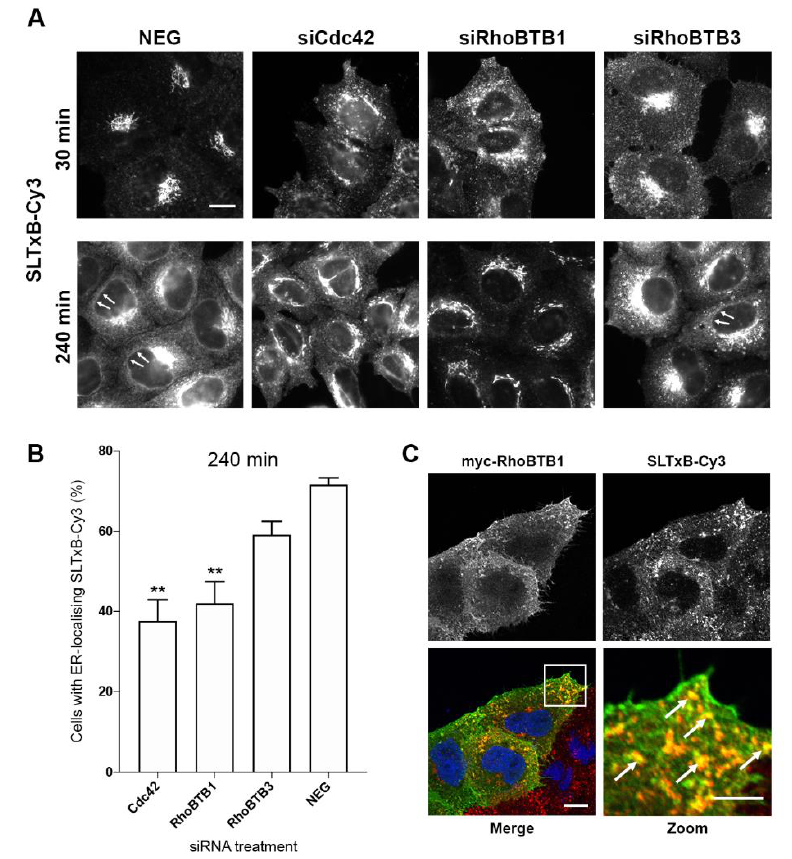
Figure 4. RhoBTB1 depletion affects retrograde transport of SLTxB-Cy3. ( A ) Representative images of HeLa Kyoto cells treated with siRNAs for 72 h as indicated and incubated with SLTxB-Cy3 for 30 or 240 min. In NEG control siRNA-treated cells, SLTxB-Cy3 is present at the Golgi complex after 30 min of incubation and at the ER after 240 min of incubation at 37 °C, as seen by the presence of the nuclear envelope signal (arrows). Bar represents 10 μm. ( B ) Graph of the mean % of cells displaying ER-localising SLTxB-Cy3 after 240 min of incubation in cells treated with siRNAs for 72 h, as indicated. Results are presented as mean ± s.e.m. of three independent experiments, with a total of at least 220 cells analysed. ** p < 0.01 compared with NEG control cells. ( C ) HeLa Kyoto cells were transfected with a DNA construct encoding myc-RhoBTB1 for 18 h and then incubated with SLTxB-Cy3 for 30 min. Arrows indicate myc-RhoBTB1 (green) and SLTxB-Cy3 (red) co-localising punctate structures. Bars represent 10 μm (merge) and 5 μm (zoom).